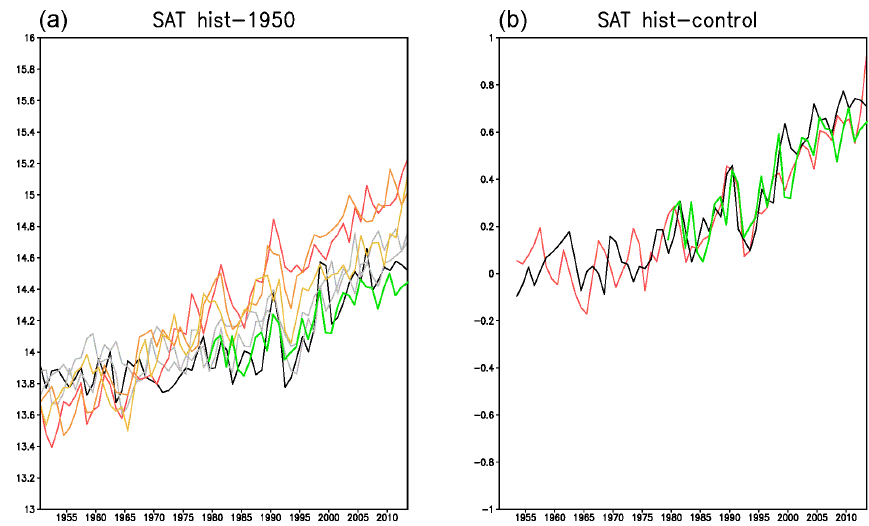
Figure 18. Global mean averaged annual SAT ( ◦ C) in hist-1950 (a) for the three members of EC-Earth3P (red colors) and EC-Earth3P-HR (grey colors). (b) Mean ensemble difference between hist-1950 and control-1950 for EC-Earth3P (red) and EC-Earth3P-HR (black). ERA5 is indicated by the green curves. Panel (b) is scaled so that the starting point fits with the EC-Earth